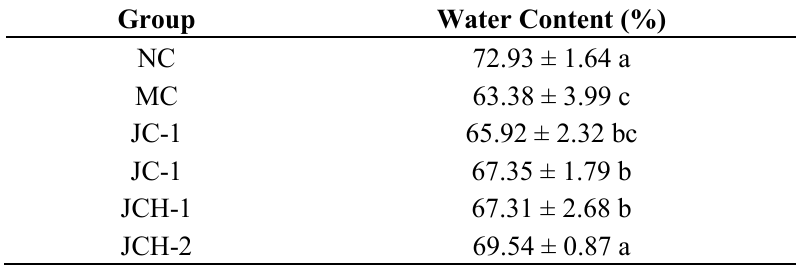
Table 1. Effects of JC and JCH on water contents of photoaging mice skin ( n =